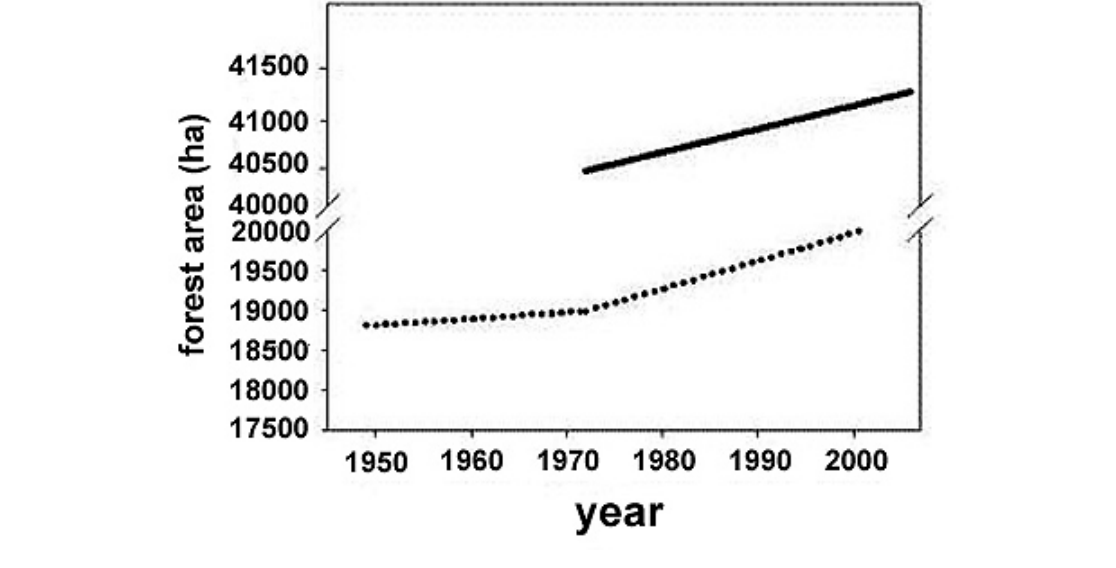
Fig. 4. Changes in the area of forest; the solid line represents the complete study area, the dotted line represents the area included in the 1949 aerial